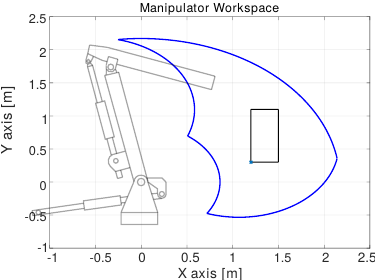
Figure 2: Desired tool center trajectory within the manipulator’s